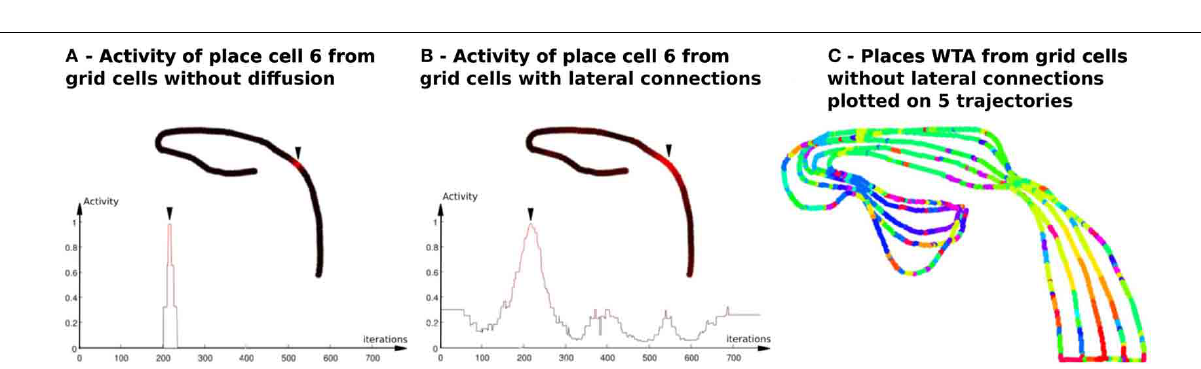
FIGURE 4 | Activity of place cells predicted by grid cells (model relying on a WTA)—Impact of the diffusion mechanism on GC networks (Experiment 6). (A) PredVPC from binary grid cells (without lateral connections). Top : Activity of the 6th PredVPC is recorded in space along a multi-room path ( path 1 described in Section 2.5.2). A red color means a high activity and a black one indicates a low activity. Location of the cell numbered 6 in the path is marked by an arrow. Bottom: Activity of the 6th PredVPC is recorded in time. On the x axis, iterations are proportional to the distance the robot has traveled (constant speed). The place field is a thin three-steps stair shaped. (B) PredVPC from grid cells with lateral connections (positive weights that decrease as a function of the distance with neighboring neurons). Top : Activity of the 6th PredVPC is recorded in space along the same path than in panel (A) .